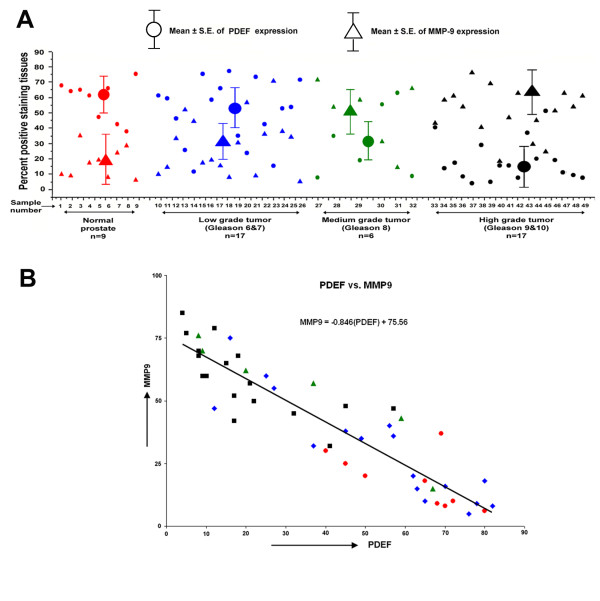
Relationship between PDEF and MMP9 expression in human prostate tissue: A, Expression of PDEF and MMP9 in individual samples B) Regression plot of the data presented in A. Data were collected from the immunohistochemistry performed for PDEF and MMP9 as described for Figure 1 and 6. (Normal = red; Gleason 6 & 7 = blue; Gleason 8 = green; and Gleason 9 and 10 = black). By regression analysis, there is a significant 0.846 (UNITS) drop in MMP9 for every 1.0 (UNIT) increase in PDEF.